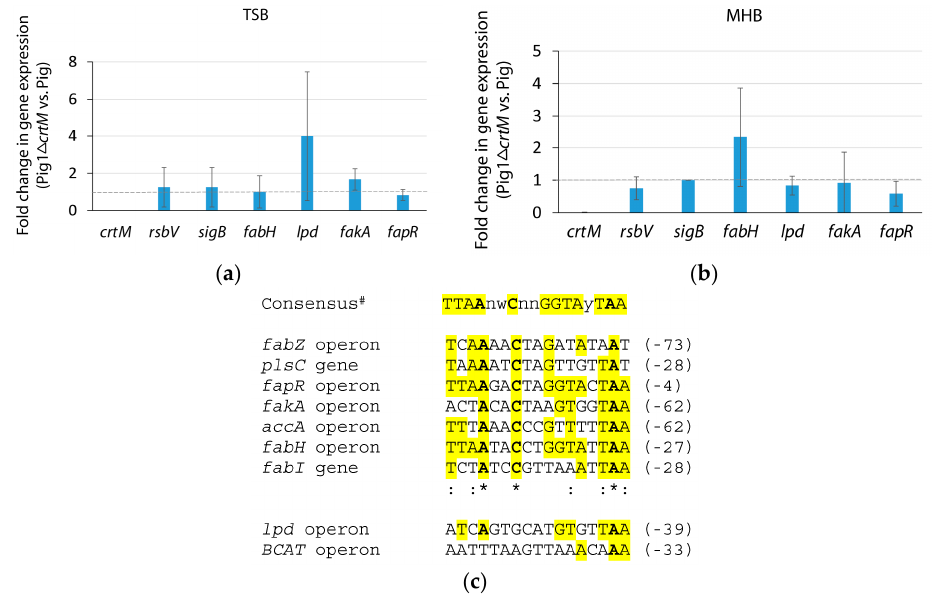
Figure 3. Transcription of fatty acid biosynthesis genes is typically unaffected by the loss of staphyloxanthin production in S. aureus . ( a ) Fold change in gene expression in Pig1 Δ crtM compared to that in Pig1 grown in TSB; ( b ) Fold change in gene expression in Pig1 Δ crtM compared to that in Pig1 grown in MHB; ( c ) FapR recognition sequence (operator sequence) in the gene or operon involved in fatty acid biosynthesis and regulation in S. aureus NCTC 8325. The transcriptional level of each gene was normalized to that of 16SrRNA. The dashed line in ( a , b ) indicates similar level of gene expression in the Pig1 pair strains. fabZ operon, SAOUHSC_02337 – 02336 ; plsC ,